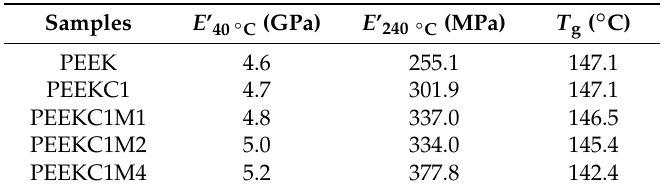
Figure 7. ( a ) Storage modulus E ’ and ( b ) tan δ as a function of temperature, at the frequency of 1 Hz, for PEEK nanocomposites. Table 2. Storage modulus E ’ at 40 and 240 °C , and glass transition temperature T g for PEEK nanocomposites obtained from DMA data in Figure 7.